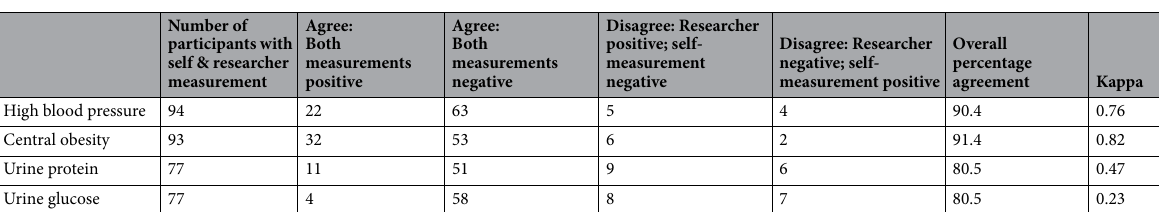
Table 3. Comparison of self-measurement and researcher measurement used to classify: high blood pressure, central obesity, presence of protein in urine and presence of glucose in urine.